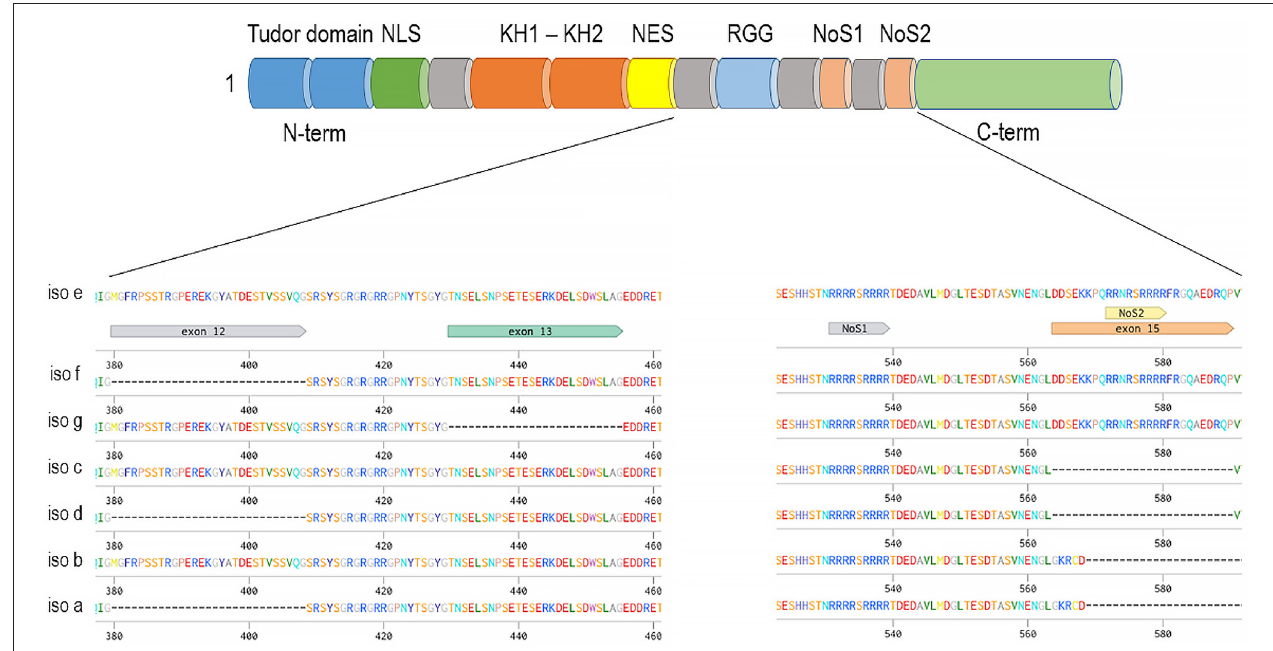
FIGURE 2 | Fxr1 gene (mouse gene depicted as an example) alternatively spliced mRNAs and common domain structure on example of the longest isoform—e. The presence of exon 15 provides an additional nucleolar targeting signal.